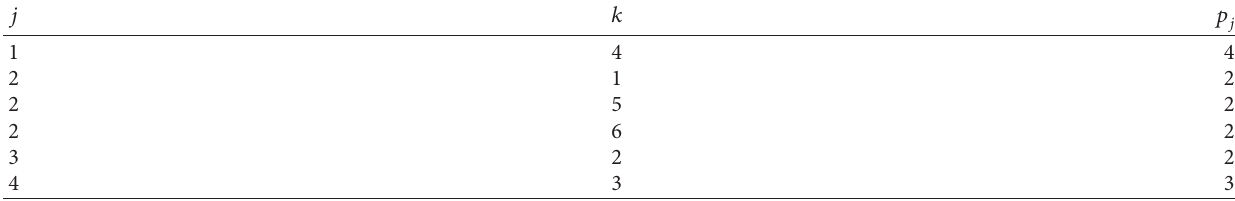
Table 4: Amount of products produced when a tool is set up.